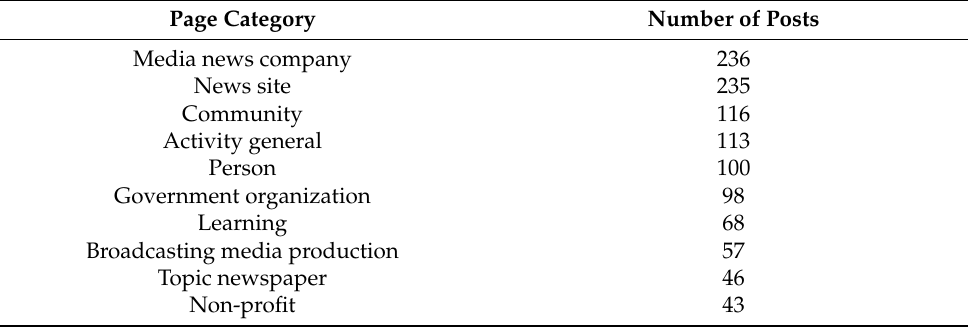
Table 2. Number of Facebook posts for each page category.